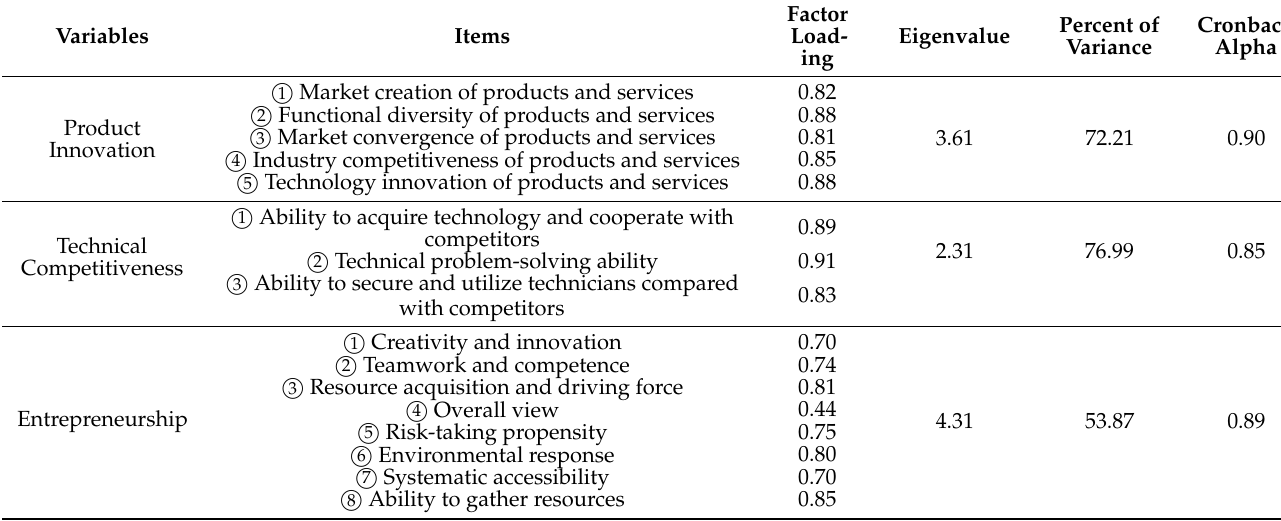
Table A1. Validity and Reliability of Measures.